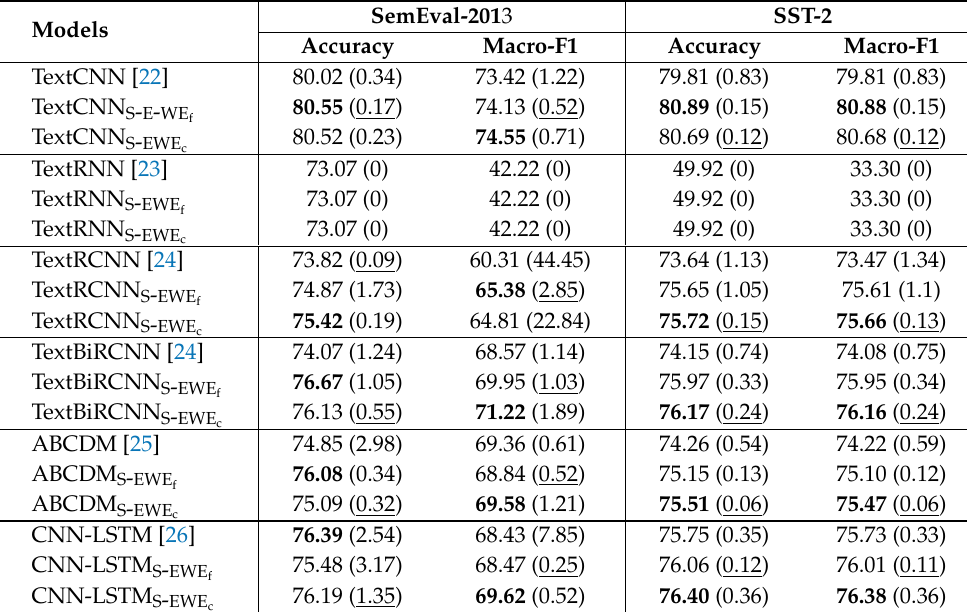
Table 5. The accuracies and macro-F1 scores of different models using Word2Vec with and without S-EWE c and S-EWE f on SemEval-2013 and SST-2 datasets (%). For each model, we ran it five times to achieve five accuracy values and macro-F1 values, respectively. Then, we took their average accuracies and macro-F1 values as the final results. The value in parentheses is the variance of the five values for each model. The bold text represents the best result achieved by each model, and the underlined text stands for the lowest variance achieved by each model.